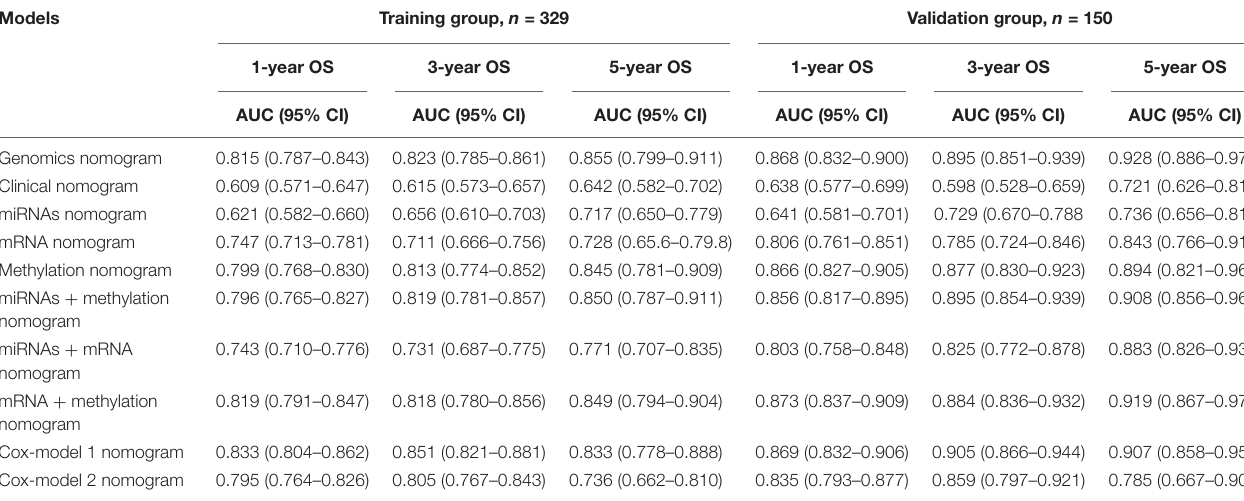
FIGURE 5 | Time-dependent receiver operating characteristic curves on 1, 3, and 5 years of genomics nomogram. Calibration plot showing 1-, 3-, and 5-year overall survival (OS) probability: the nomogram-estimated OS is plotted on the x-axis, and the actual OS is plotted on the y -axis. The diagonal dotted line is a perfect estimation by an ideal model, in which the estimated outcome perfectly corresponds to the actual outcome. The solid line is the performance of the nomogram: A closer alignment with the diagonal dotted line represents a better estimation. Decision curve analysis for genomics nomogram and clinical nomogram: the y-axis measures the net benefit. The gray line or the horizontal black line represents a follow-up of all patients or no patients. The model makes more benefit with a higher position in curve. TABLE 4 | The area under the curve (AUC) values of different genomics score models in the training group and the validation group.